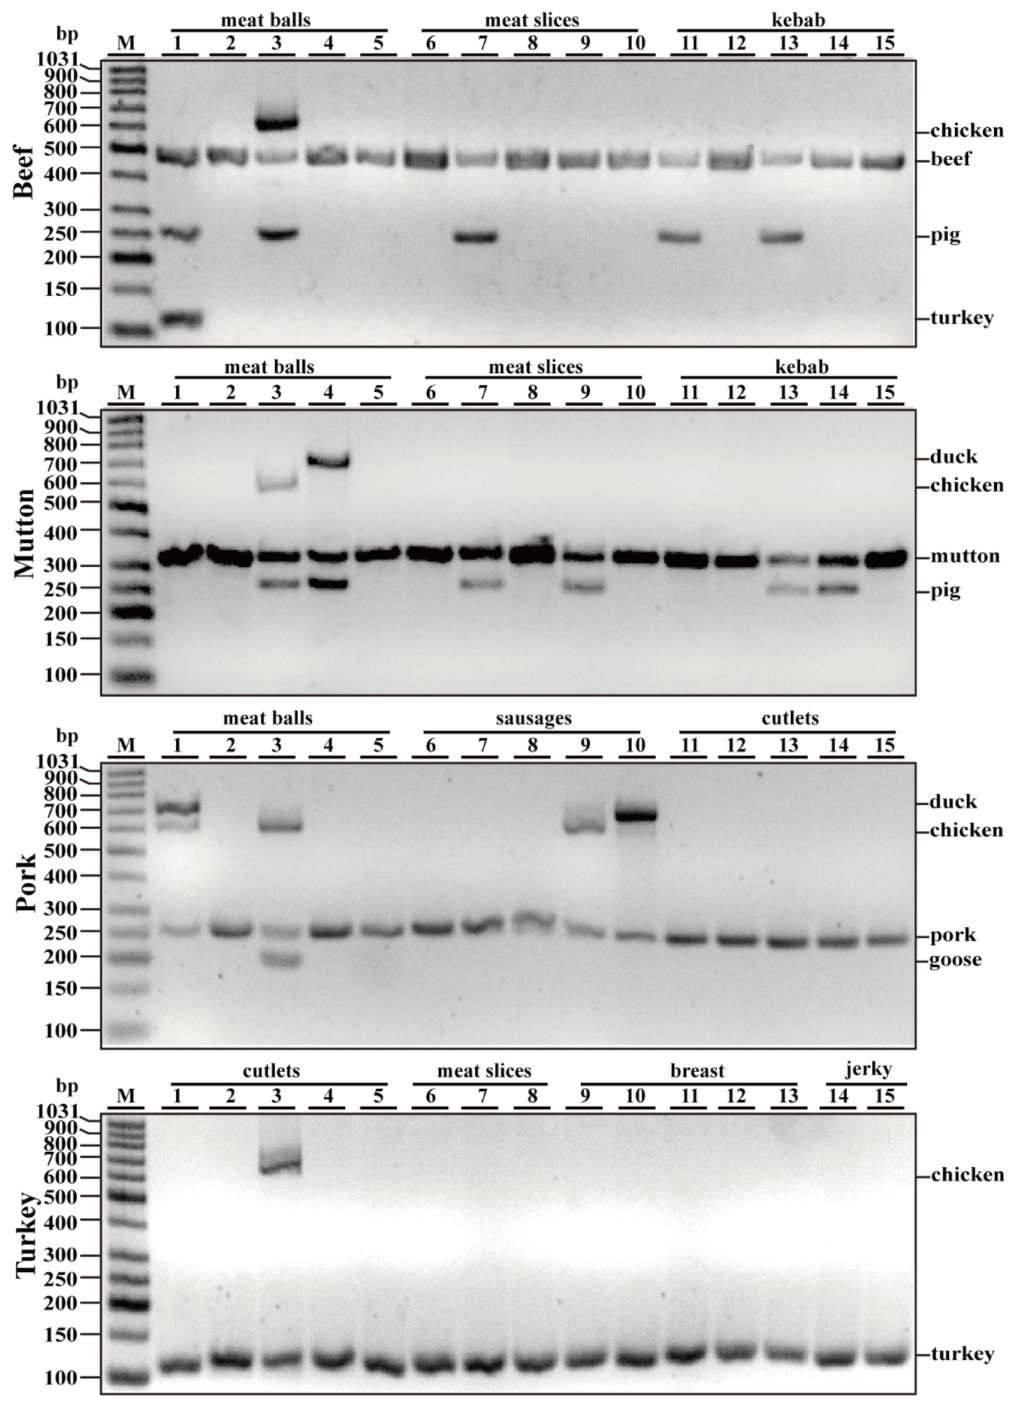
Figure 4. Analysis of commercial foodstuffs using the developed septuple assay. Gel image of the fragments generated by multiplex PCR amplifications using DNA obtained from commercial meat products with premixed primers for seven meat species including turkey, goose, pig, cattle, sheep, chicken and